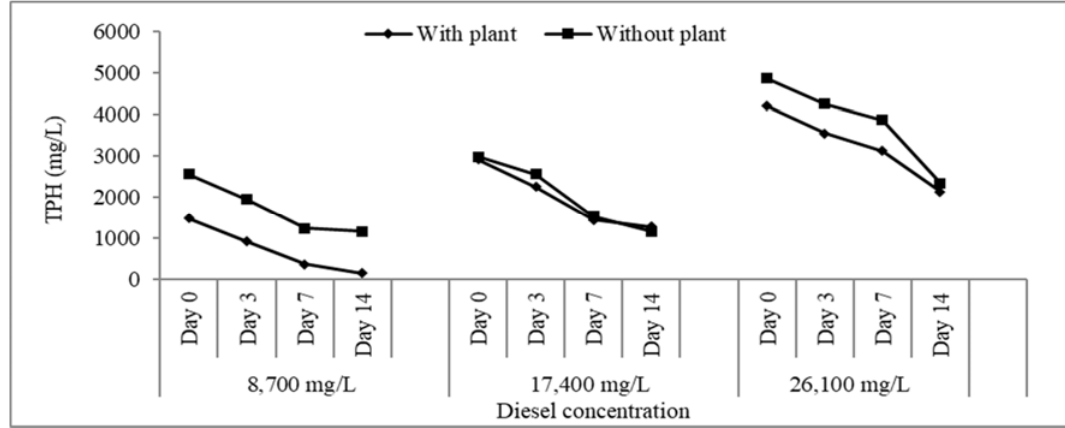
Fig. 5. TPH concentration throughout 14 day of diesel